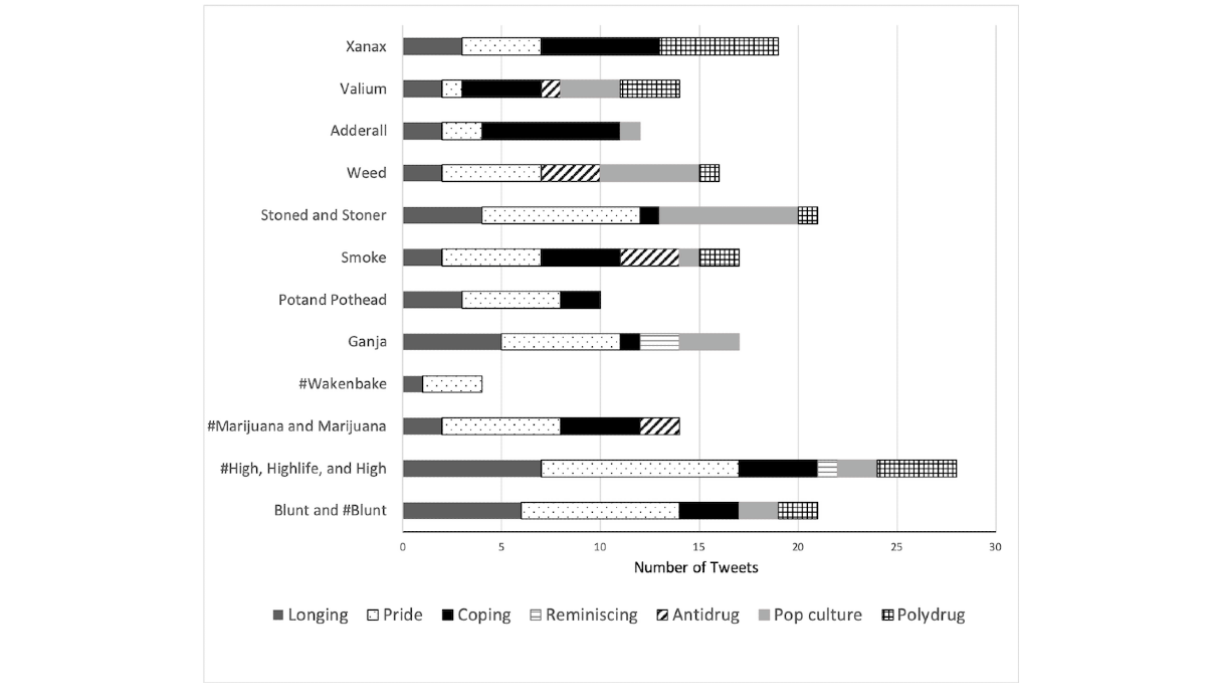
Figure 2. Frequency of themes from tweets having drug-related